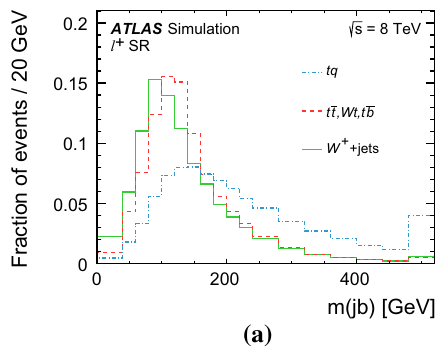
untagged jet | η( j ) | . The distributions are shown for the tq signal pro- cess, the W + +jets background and the top-quark background in the (cid:5) + SR. Events beyond the x -axis range are included in the last bin